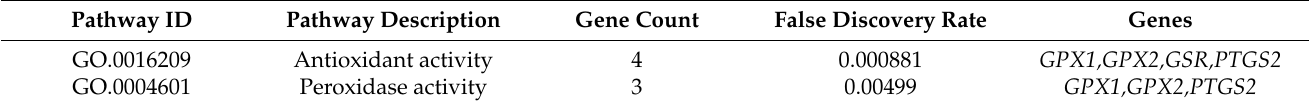
Table 7. Molecular function representation of the interacting